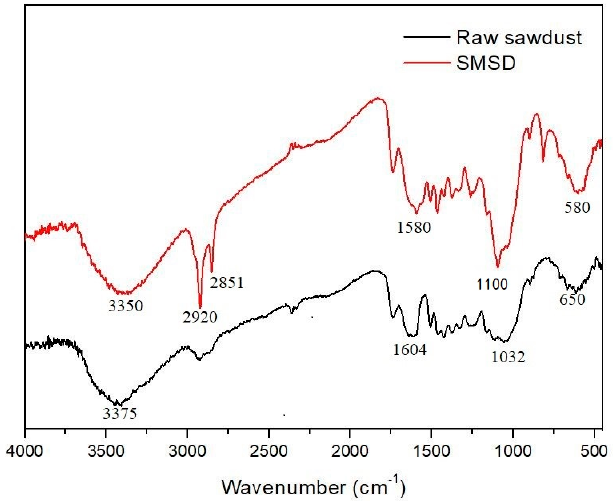
Figure 2. FTIR spectra of raw sawdust and SMSD.